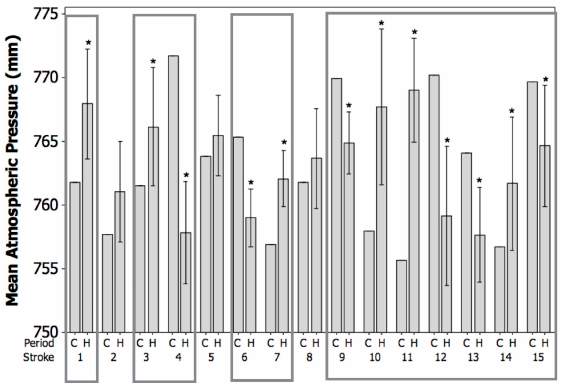
Figure 3. Mean atmospheric pressure (mmHg) in the control period (C) and the mean atmospheric pressure ±95% CI in the 7-day hazard periods (H) before the canine strokes (n = 15). Significant effects (* p < 0.05) are displayed within boxes.